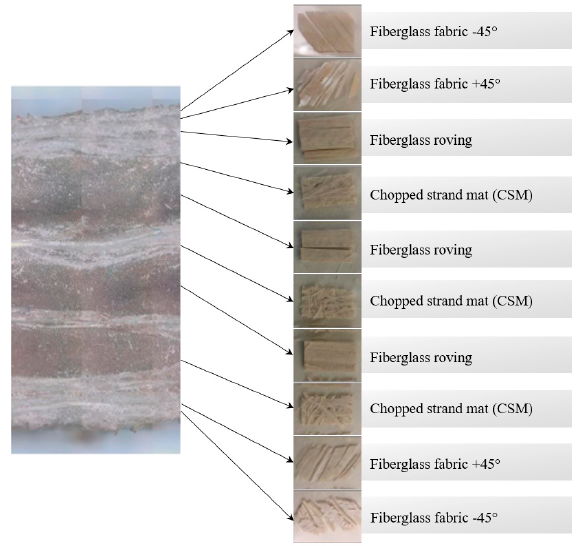
Figure 2. The construction layers of the GFRP crossarm sample [21].